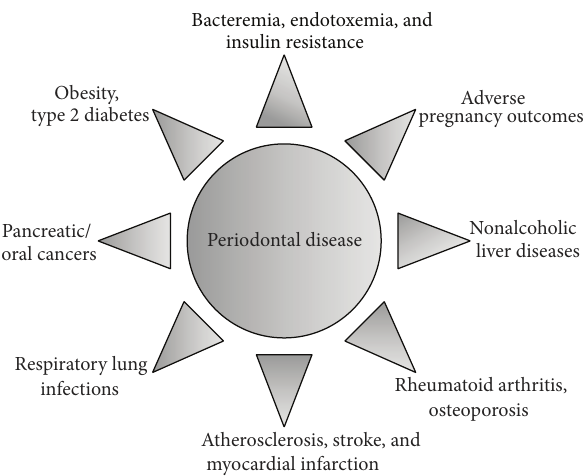
Figure 1: Diagram of periodontal disease leading to other compli-